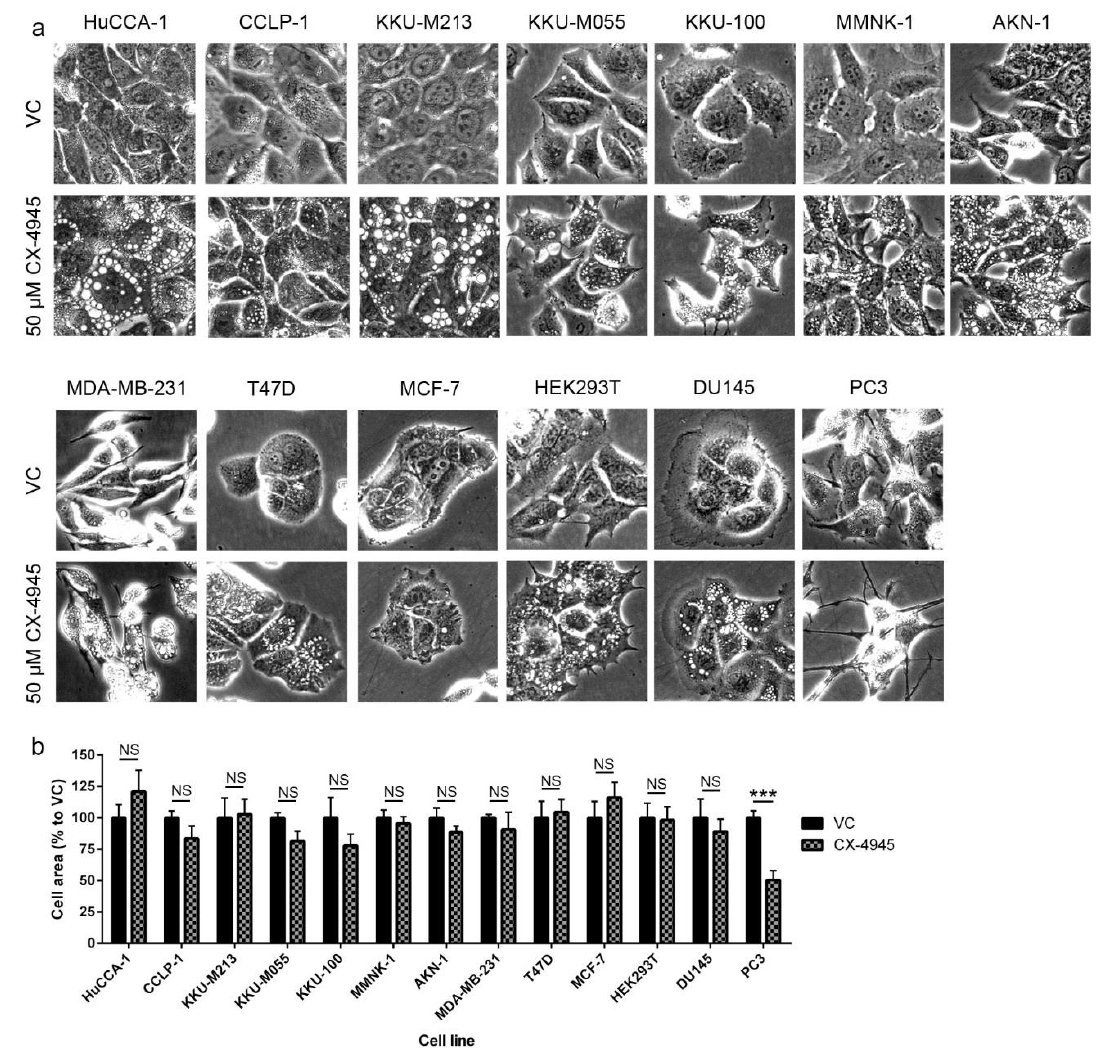
Figure 3. CX-4945 induced vacuolization in a wide range of cancer and immortalized cell lines. ( a ) CCA cells (HuCCA-1, CCLP-1, KKU-M213, KKU-M055, and KKU-100) and immortalized cholangiocytes (MMNK-1 and AKN-1), breast cancer cells (MDA-MB-231 and T48D), prostate cancer cells (DU145), and human embryonic kidney cells (HEK293T) form intensive cytoplasmic vacuoles at 4 h after CX-4945 treatment. Breast cancer cells, MCF-7, formed only few vacuoles in small number of cells, while prostate cancer cell, PC3, did not form any vacuoles. ( b ) Cell area of cell lines that formed vacuoles did not altered, but PC3 cell area decreased to approximately 50% as compared to the vehicle control group. VC; vehicle control, ***; p < 0.001, NS; not significant. Pictures are representative of the results from three independent experiments. Graphs were plotted as mean ± SEM.